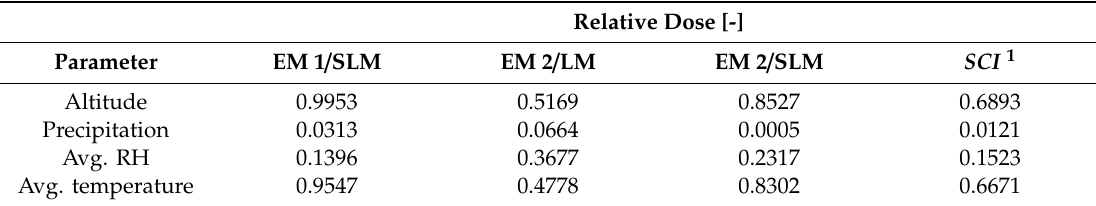
Table 2. Degree of determination R 2 for linear correlations between the relative doses based on di ff erent model combinations and the parameters altitude, precipitation, average relative humidity, and average annual temperature. Relative Dose [-] Parameter EM 1 / SLM EM 2 / LM EM 2 / SLM SCI 1 Altitude 0.9953 0.5169 0.8527 0.6893 Precipitation 0.0313 0.0664 0.0005 0.0121 Avg. RH